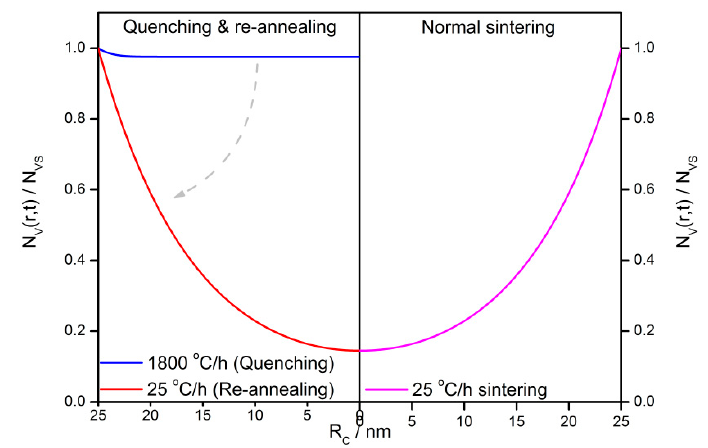
Figure 16. The steady-state oxygen vacancy distribution profiles in a 25-nm grain with normal sintering ( β = 25 °C/h), quenching ( β = 1800 °C/h), and re-annealing ( β = 25 °C/h).